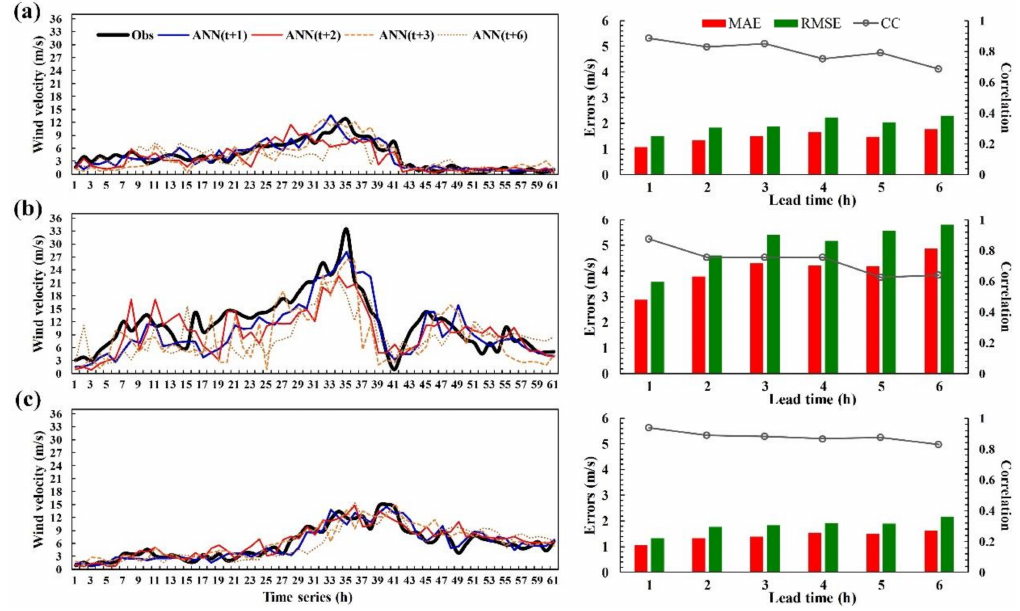
Figure 9. Comparisons between records and 1- to 6-h lead predictions for Megi in 2016: ( a ) Hsinchu, ( b ) Wuqi, and ( c ) Kaohsiung